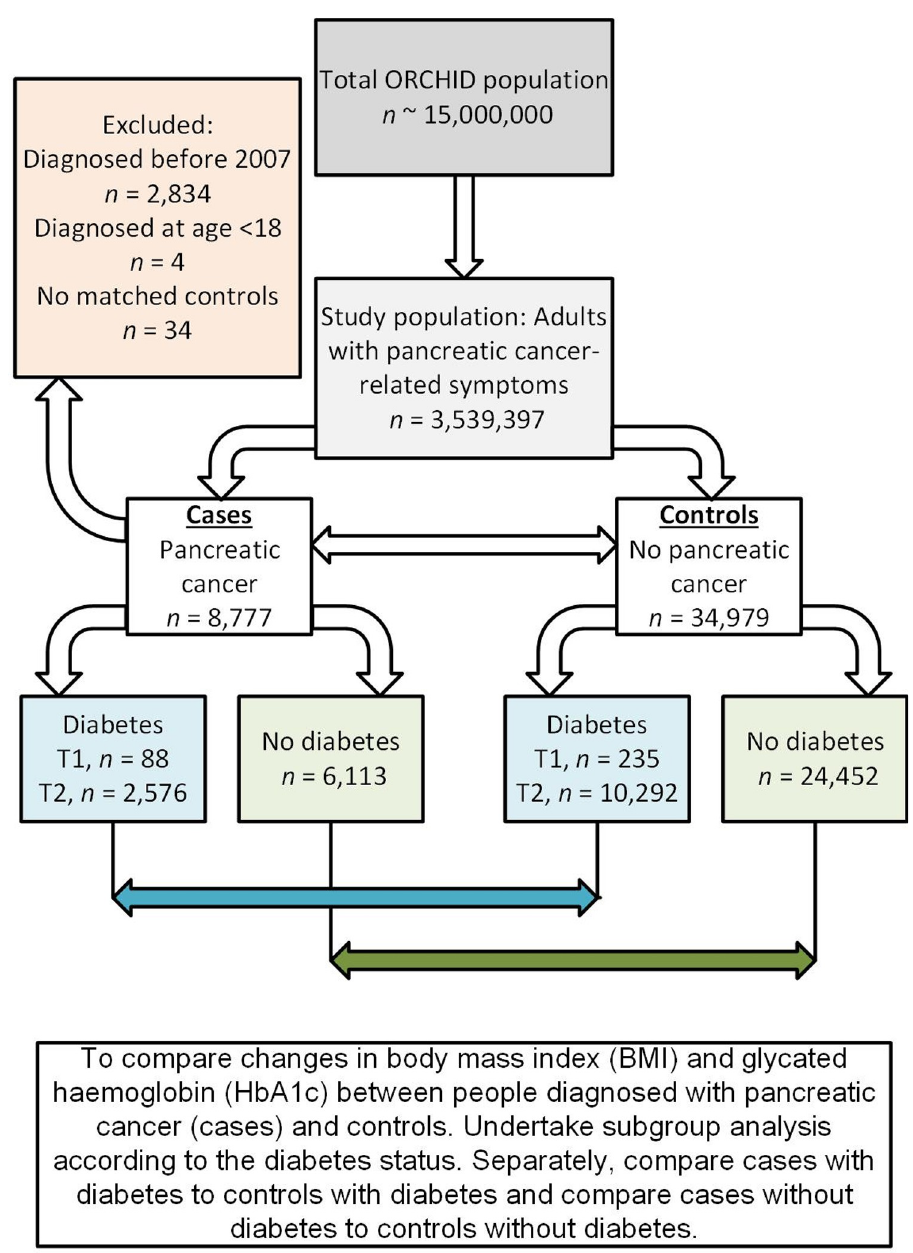
Fig 1. Study participants, a consort diagram illustrating the construction of the case-control dataset and plan of the analysis to fulfil the aims and objectives of this study.